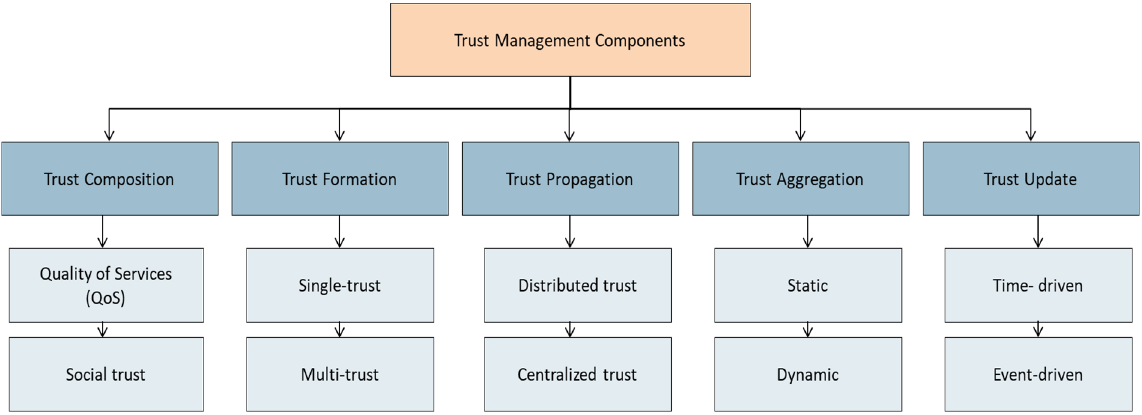
Figure 2. Trust management model components.